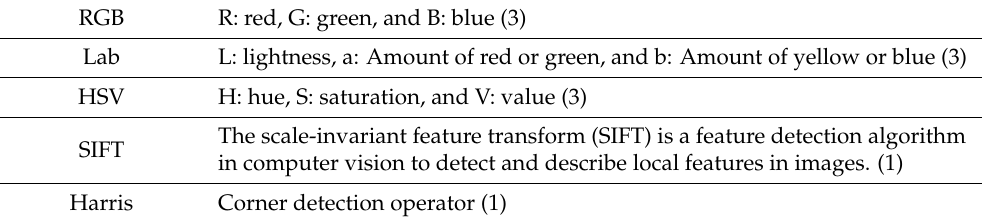
Table 2. Features Extracting.